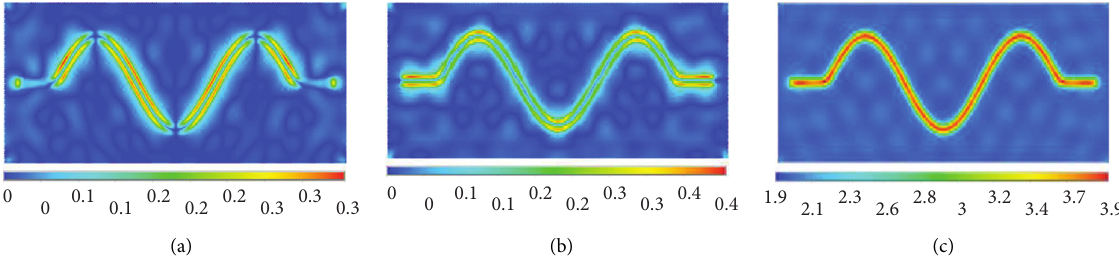
Figure 54: P wave incident (NR � 3, f � 2.0Hz, H � 100m, and C